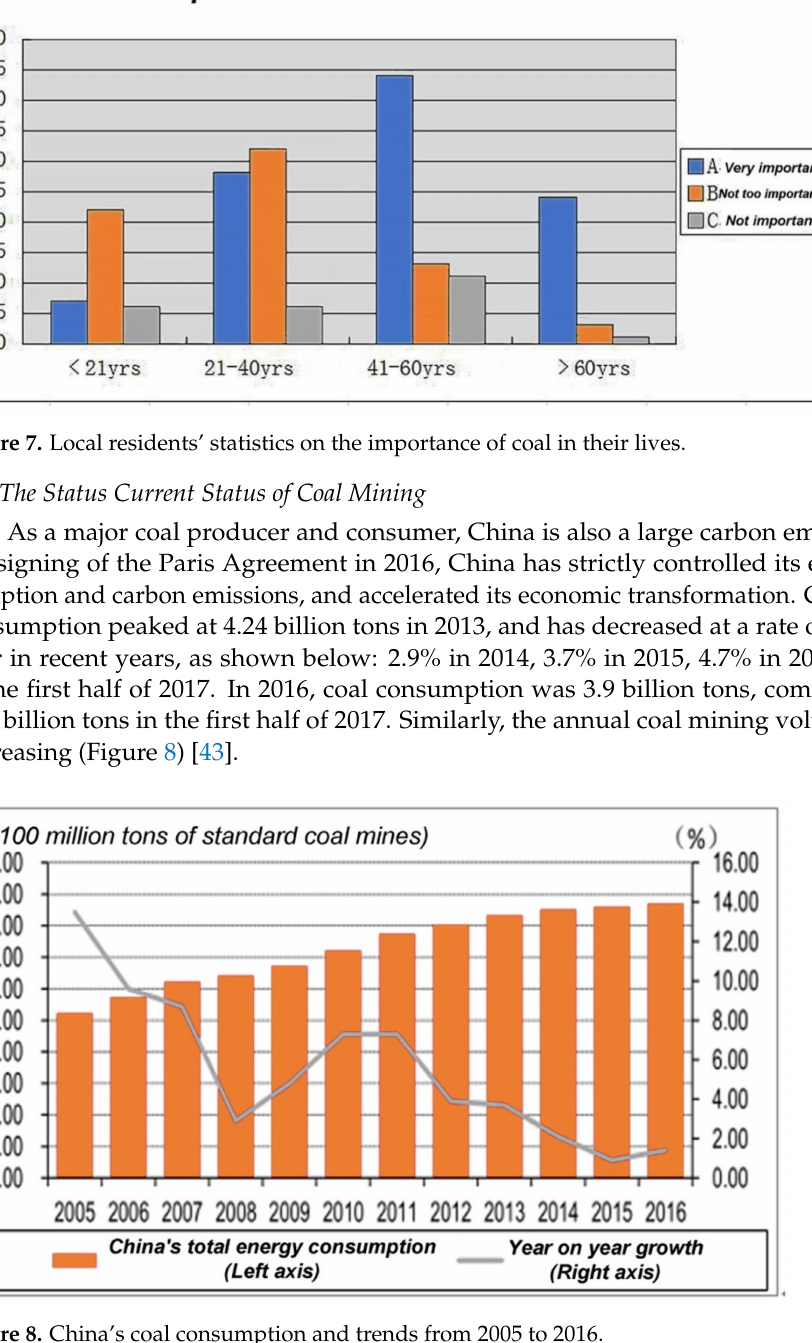
Figure 8. China’s coal consumption and trends from 2005 to